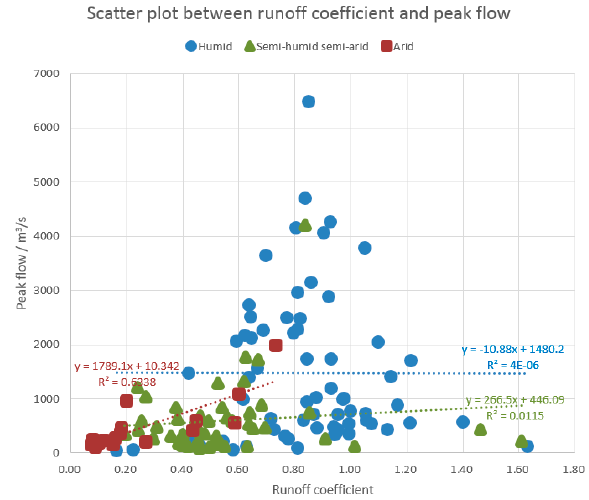
Figure 5. Scatter plot between runoff coefficient and peak flow (exclude runoff coefficient larger than 1).